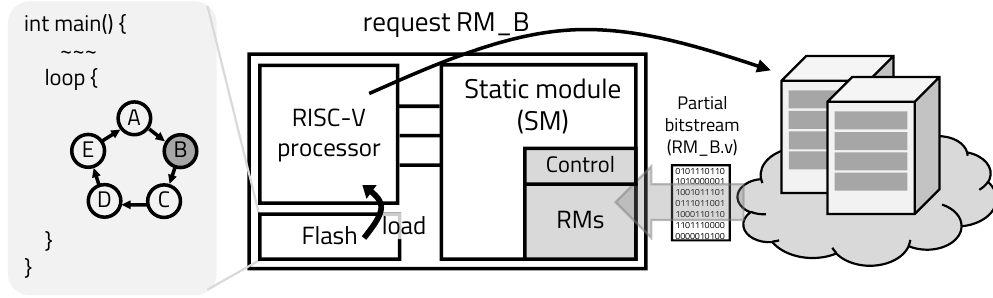
Figure 6. mIoT edge device